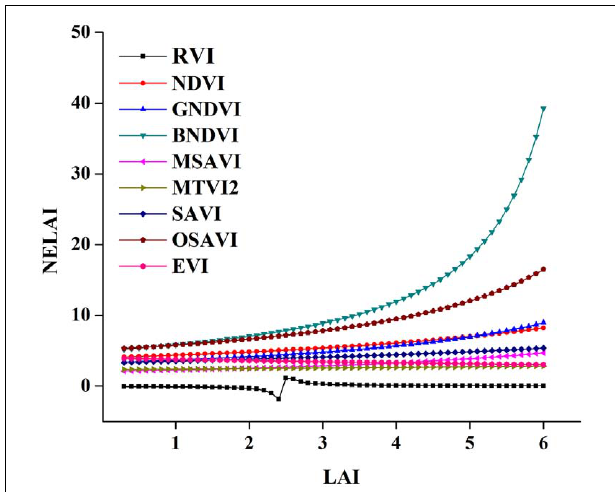
FIGURE 13 | Sensitivity analysis for nine spectral VIs tested to